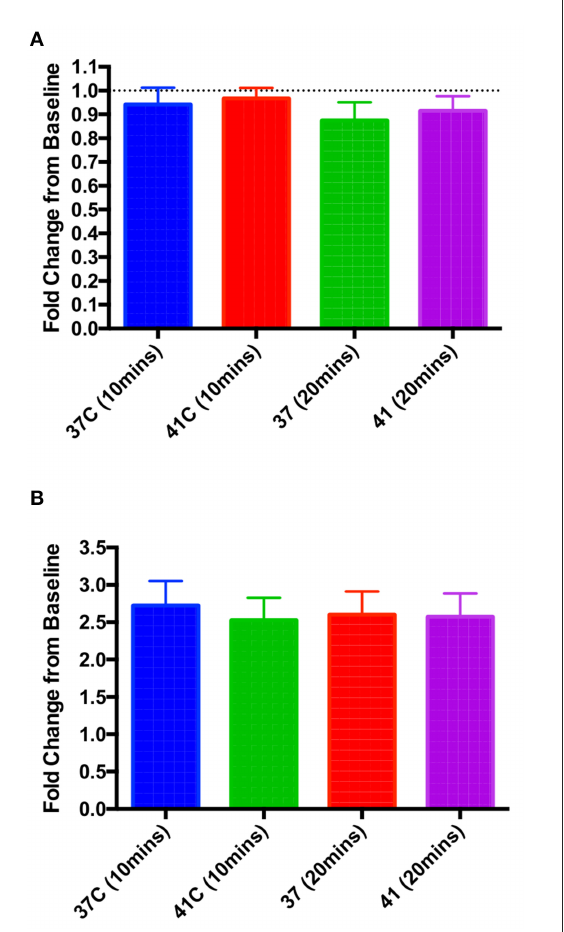
FIGURE5 In vitro hyperthermia had no significant effect on either baseline contractility at 10 or 20min post-temperature change (A) or the increase in contractility when 10 − 6 M isoproterenol was applied at either 10 or 20min post-isoproterenol (B) . One-way ANOVA, n = 9 and 10 cells (A) , 8 and 7 (B) , 37 and 41 ◦ C,